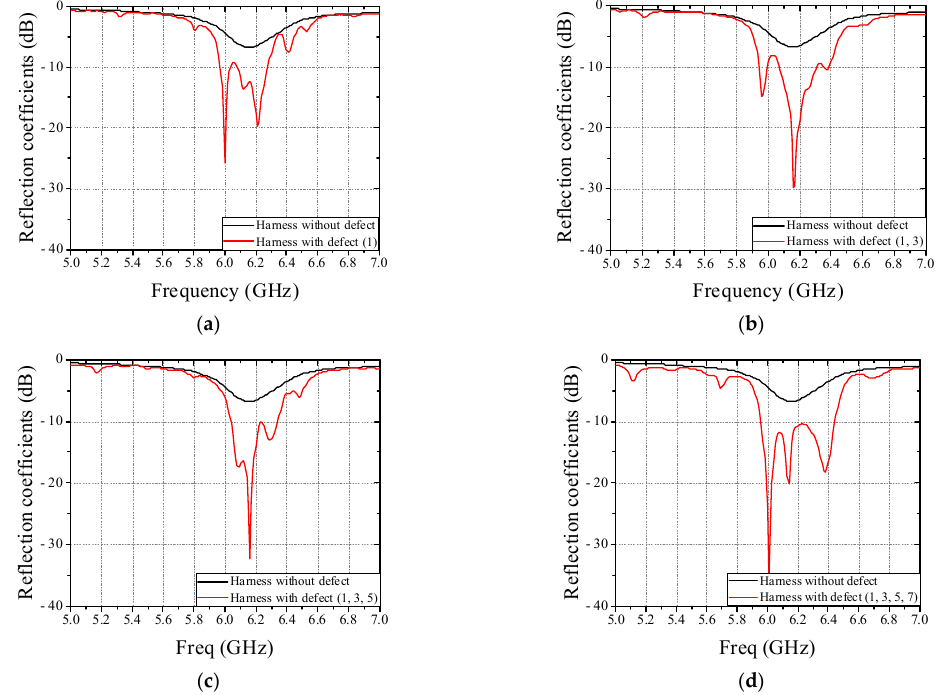
Sensors 2022 , 22 , x FOR PEER REVIEW 11 of 12 Figure 10. Measured reflection coefficients of patch antenna in cases of real flat harness (7 wires) without and with defect according to defect location. ( a ) Defective wire: 1. ( b ) Defective wire: 1 and 3. ( c ) Defective wire: 1, 3, and 5. ( d ) Defective wire: 1, 3, 5, and 7.